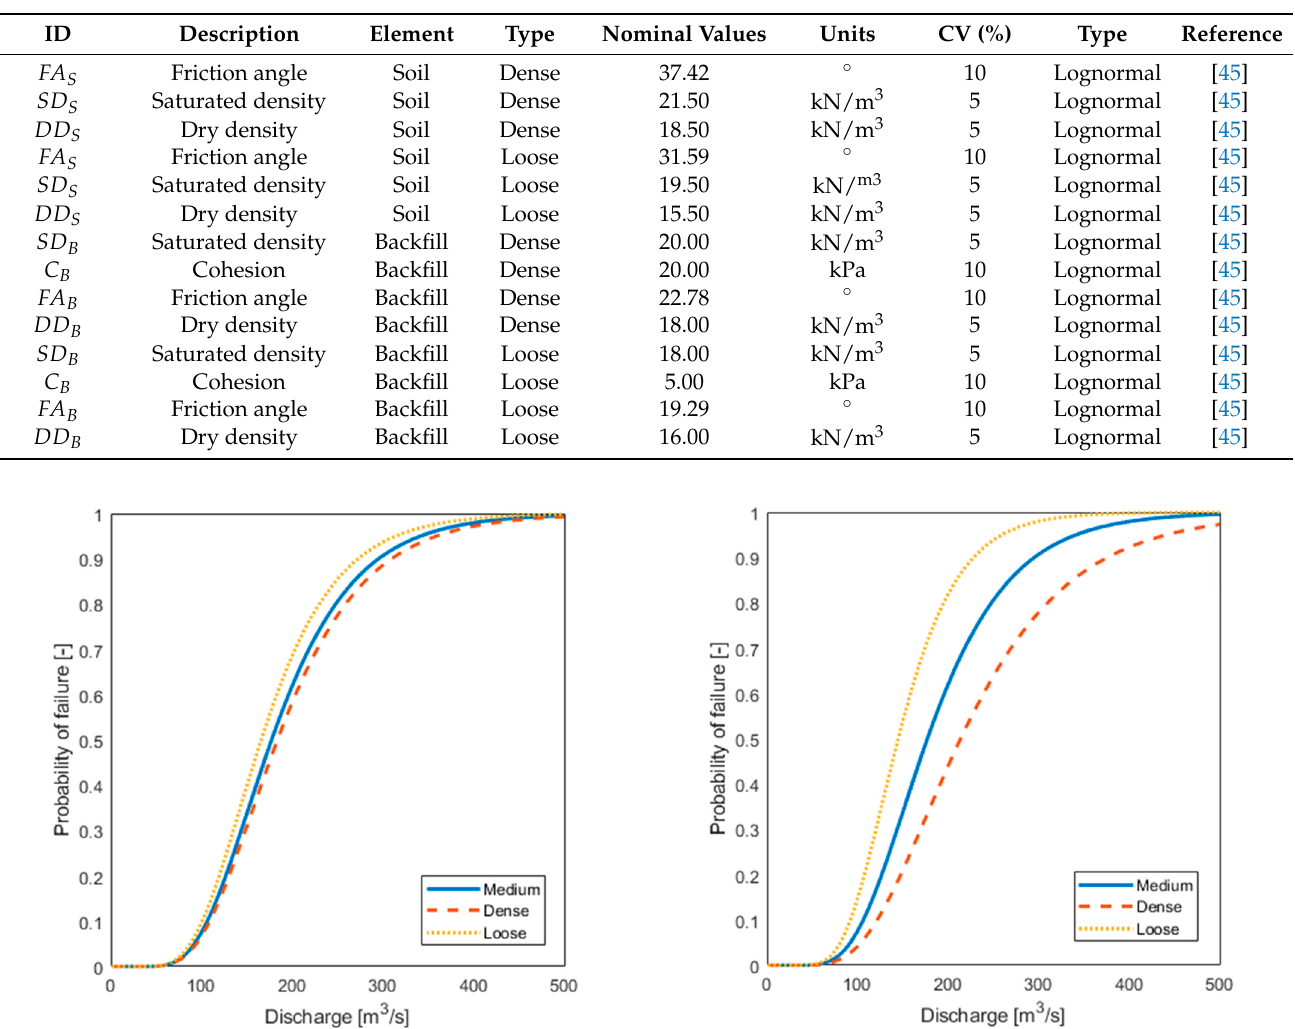
Table 3. Random variables for the parametric analysis.